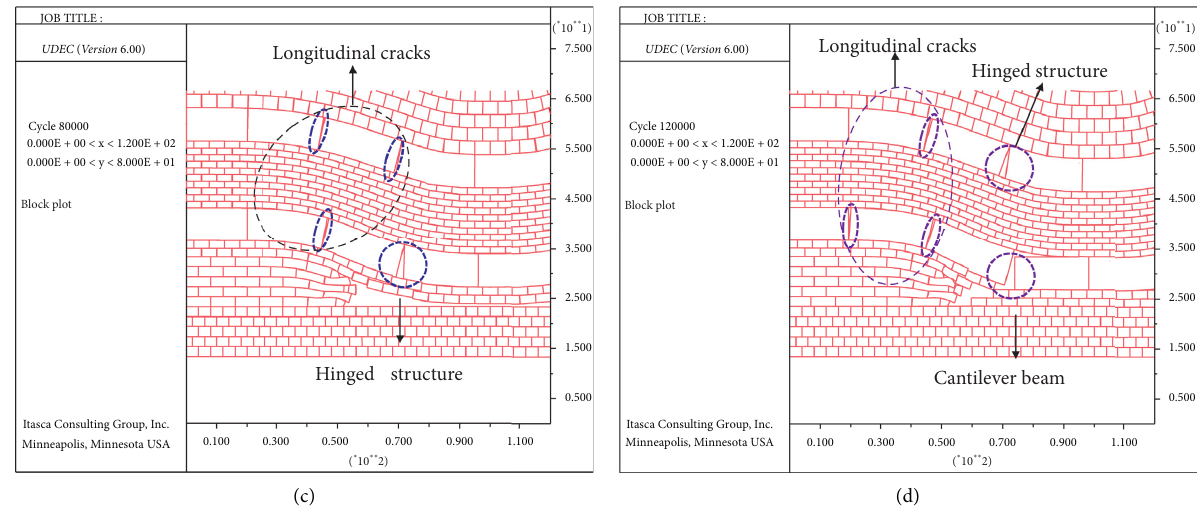
Figure 12: Structure failure process of key stratum in different cycles. (a) Cycle 10000. (b) Cycle 50000. (c) Cycle 80000. (d) Cycle 120000.